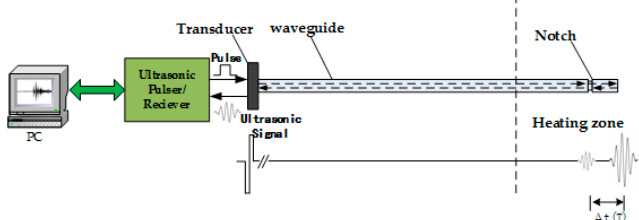
Figure 1. Structure diagram of temperature measurement system established via ultrasonic pulse method.